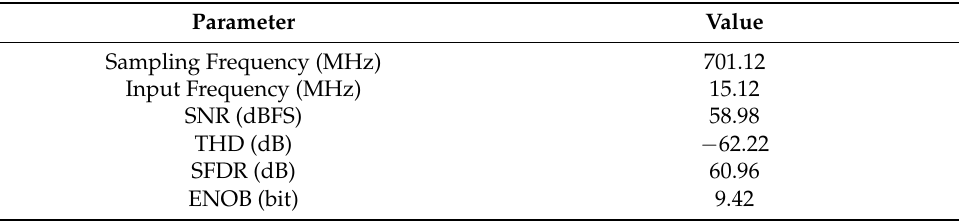
Table 5. Simulation test results of different frequency points